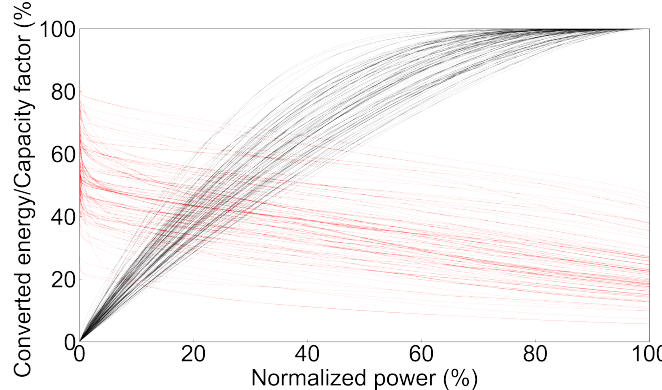
Figure 11. Normalized extracted energy (black) and capacity factor (red) for ideal converters as a function of their capacities Each line corresponds to one of the 100 selected transmission